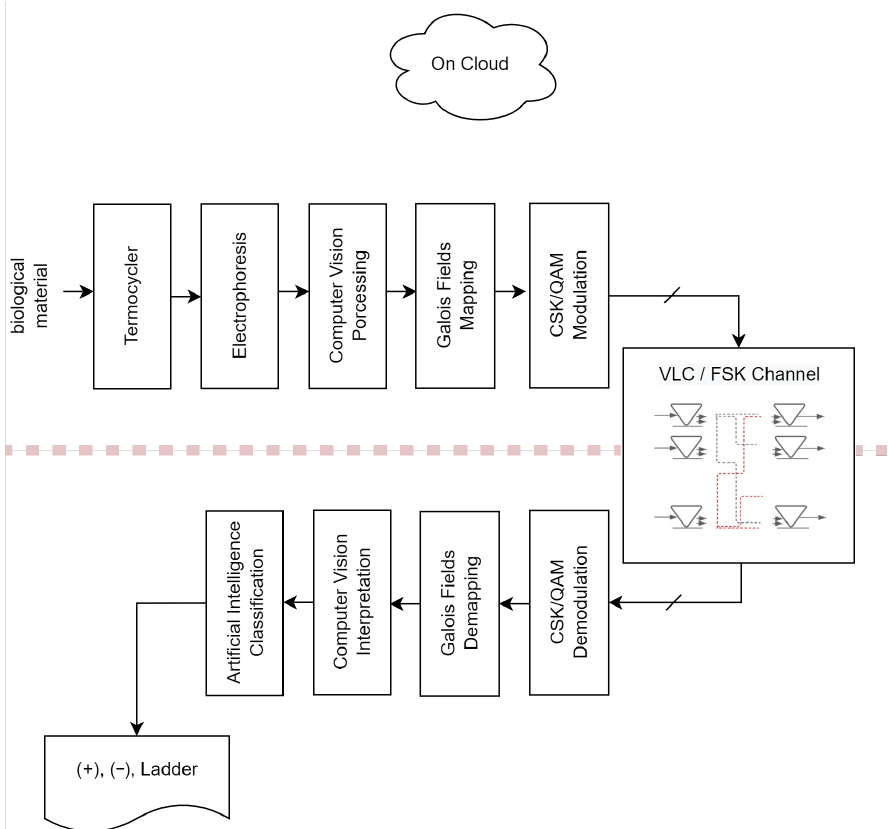
Figure 1. System diagram for the phases of model searching and operation of the classification